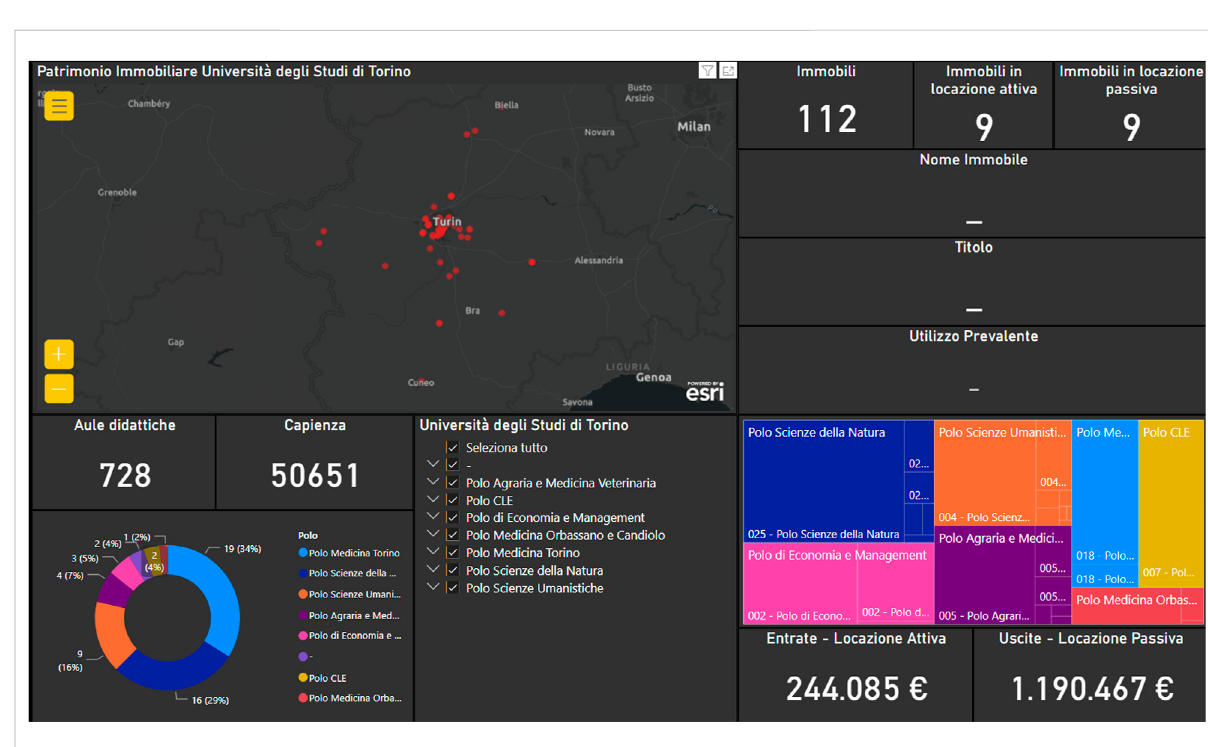
FIGURE 9 Overall analytic dashboard of UniTO asset with information fi ltered by the educational